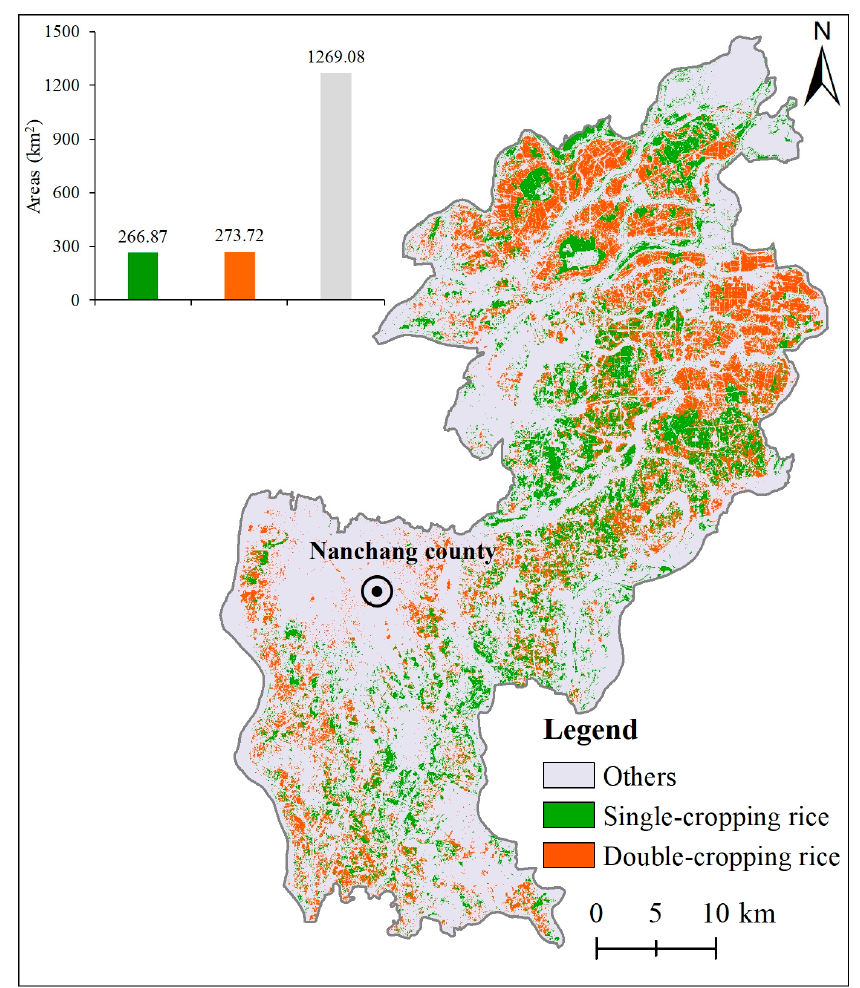
Figure 9. Map of rice paddy planting areas and multi-cropping pattern in Nanchang County in 2015. The inset at top left shows the total land area of each category.